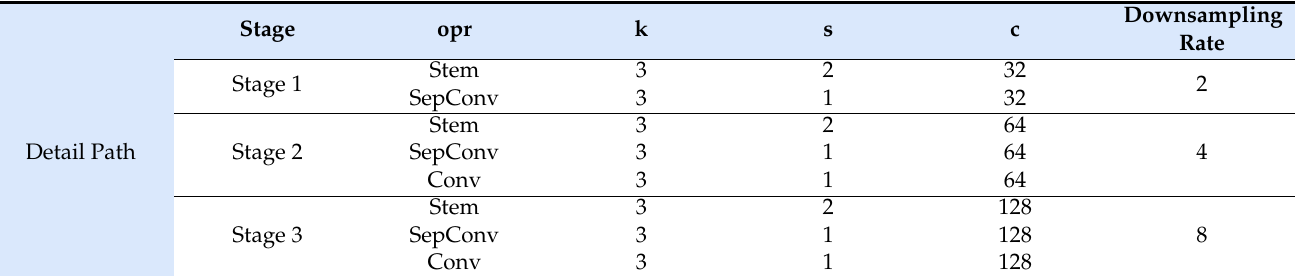
Table 1. Illustration of instantiation of the Detail Branch Each layer contains one or more operations (SepConv: depth-wise separable convolution). Each operation (opr) has a kernel size k, stride s, output channels c and a downsampling rate.